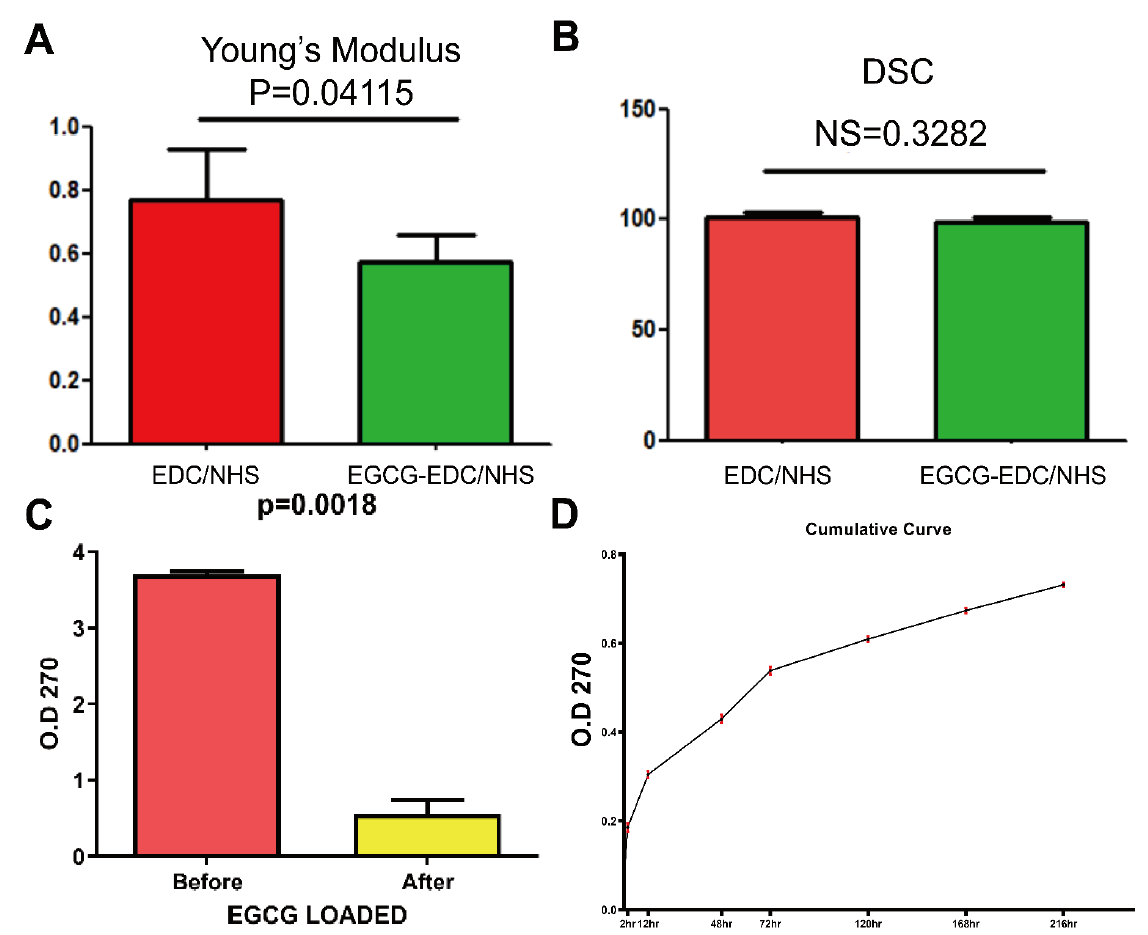
Figure 3. Young’s Modulus ( A ) and DSC statistics ( B ) of EDC/NHS collagen membrane and 0.064% EGCG-EDC/NHS collagen membrane. NS = no significance. ( C ) EGCG-EDC/NHS-Col fabrication assessment by detecting the OD value of EGCG solution before and after immersing membrane. ( D ) In vitro cumulative release profile of E-HA.